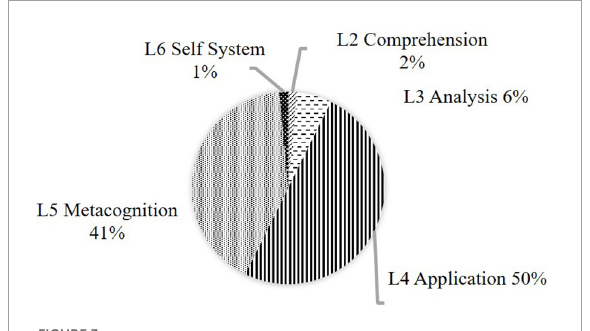
FIGURE3 Distribution of the cognitive levels of the MINEDUC Standards. FIGURE4